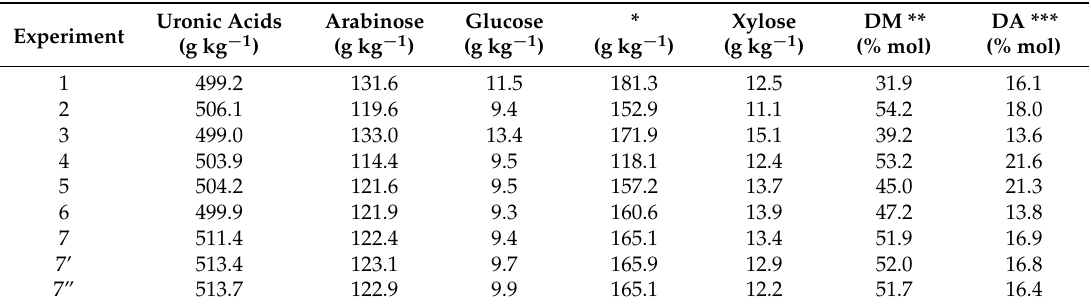
Table 3. Chemical composition, degree of methylation, and degree of acetylation of pectin obtained in hydrothermal extraction of